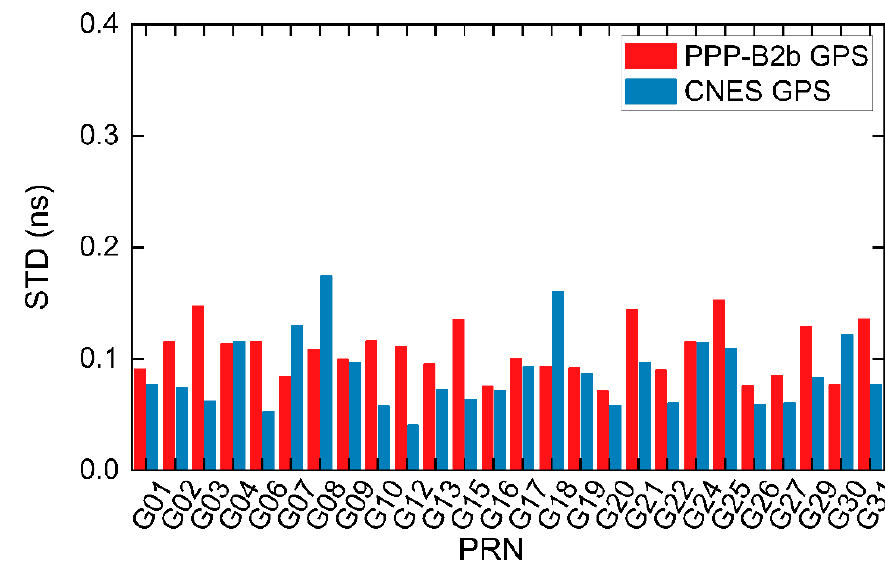
Figure 8. STDs of the PPP-B2b and CNES for GPS satellite clock.